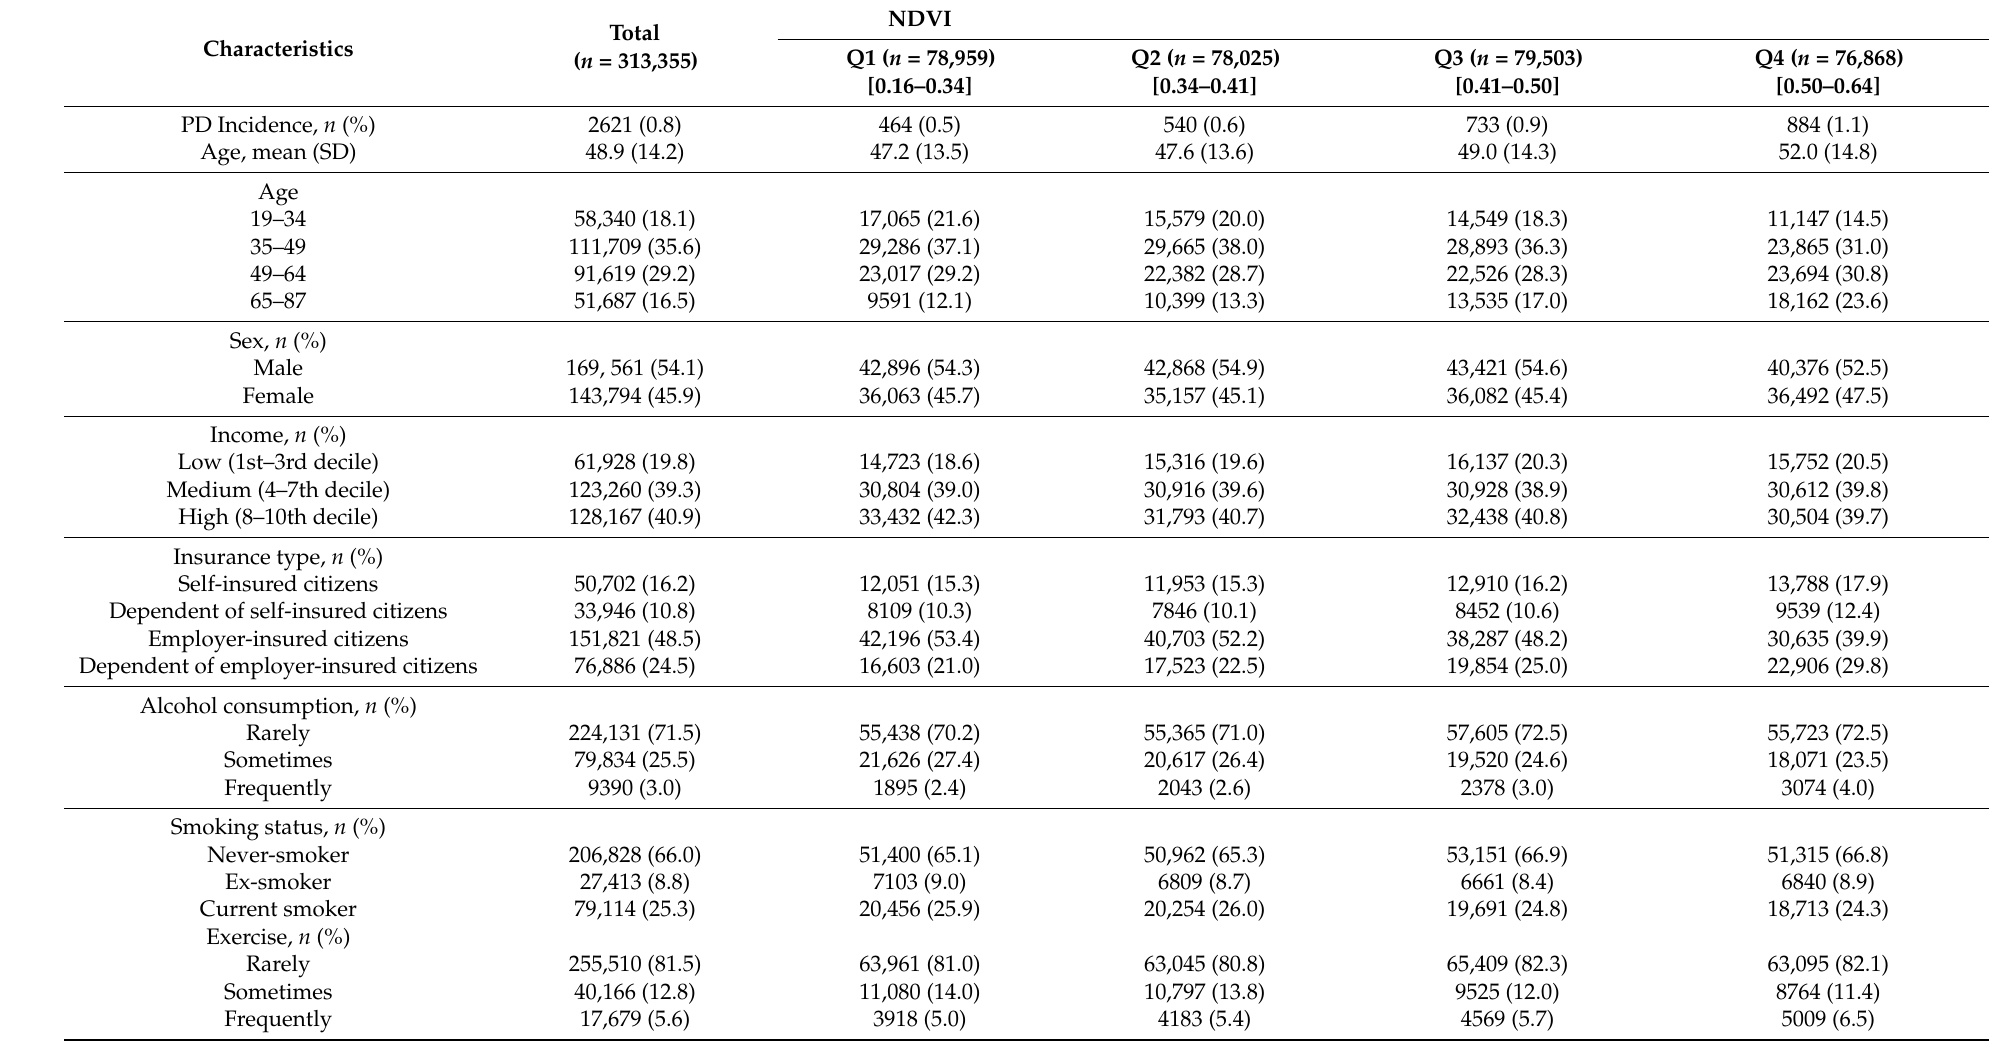
Table 1. Baseline characteristics of 313,355 participants according to quartiles of normalized difference vegetation